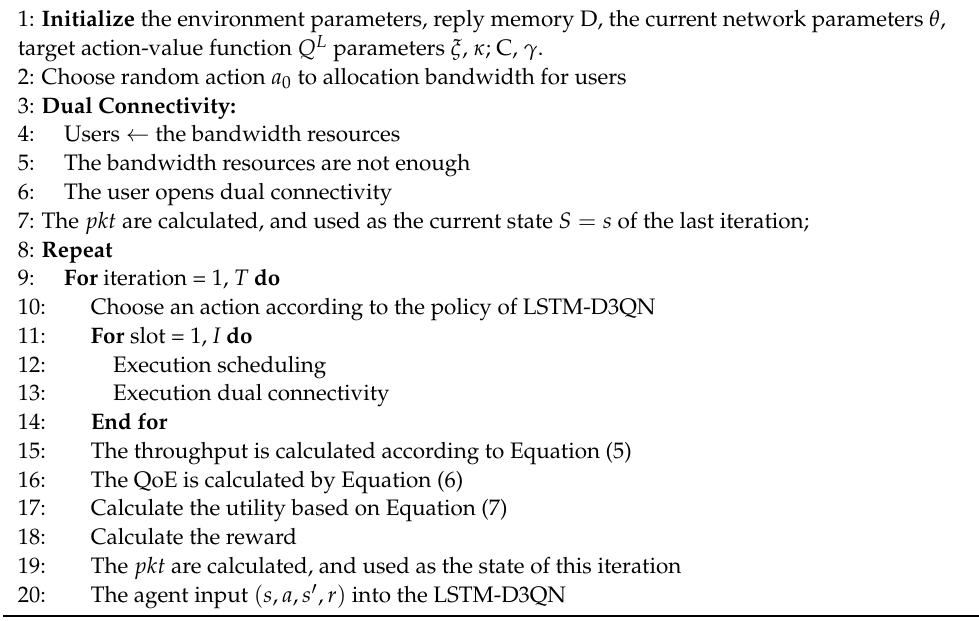
Algorithm 1 The network slicing resource allocation based on LSTM-D3QN with